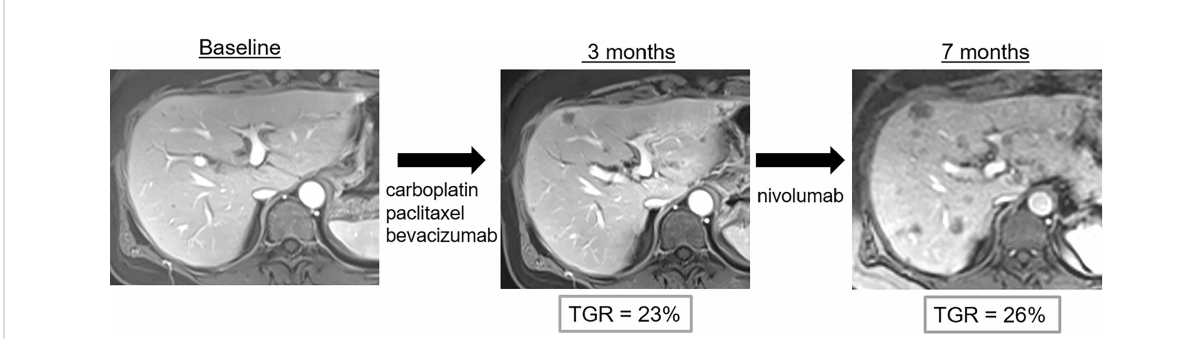
FIGURE 5 Pseudo-hyperprogression in a 53-year-old female with anal squamous cell cancer who showed disease progression following treatment with carboplatin, paclitaxel and bevacizumab. Nivolumab (anti-PD1) was then administered. Imaging follow-up showed continuous progression of liver metastases with potential hyperprogression after initiation of immune checkpoint blockade therapy. However, the tumor growth rate (TGR) did not signi fi cantly change when compared to baseline imaging. Thus, the diagnosis of hyperprogression was wrong and imaging fi ndings correspond to disease